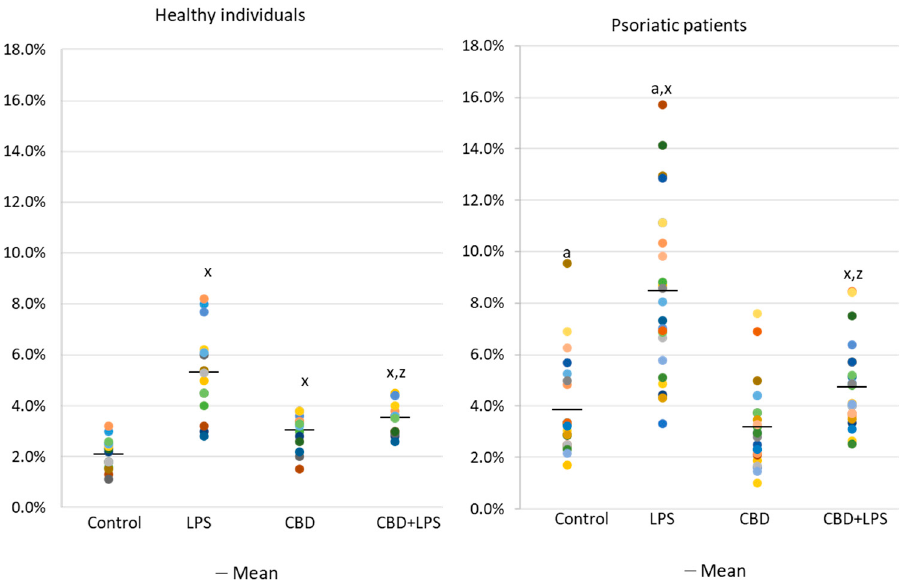
Figure 1. Percentage of neutrophils from healthy subjects ( n = 14) and psoriatic patients ( n = 28) undergoing NETosis. after 1h incubation with lipopolysaccharide (LPS), cannabidiol (CBD) and LPS with cannabidiol. a—statistically significant difference between neutrophils from patients with psoriasis vulgaris and healthy subjects p < 0.05; x—statistically significant difference between treated neutrophils (with LPS, CBD, or LPS + CBD) and non-treated (control) cells; p < 0.05; z—statistically significant difference between neutrophils treated with LPS + CBD and treated only with LPS; p < 0.05.